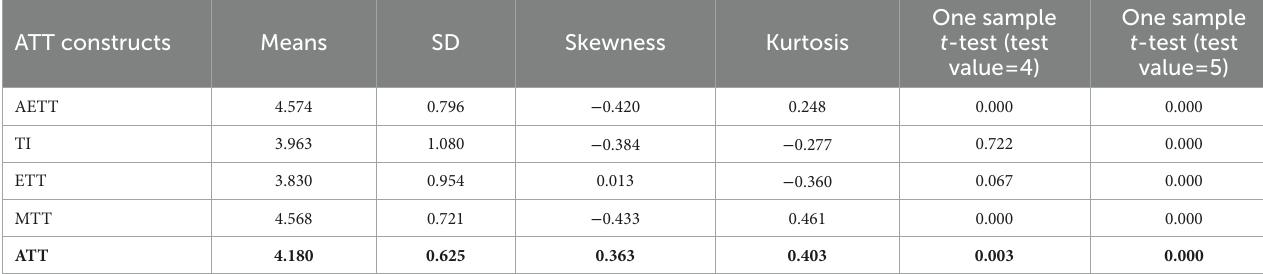
TABLE 5 Descriptive statistics and one-sample t -test results of ATT constructs.